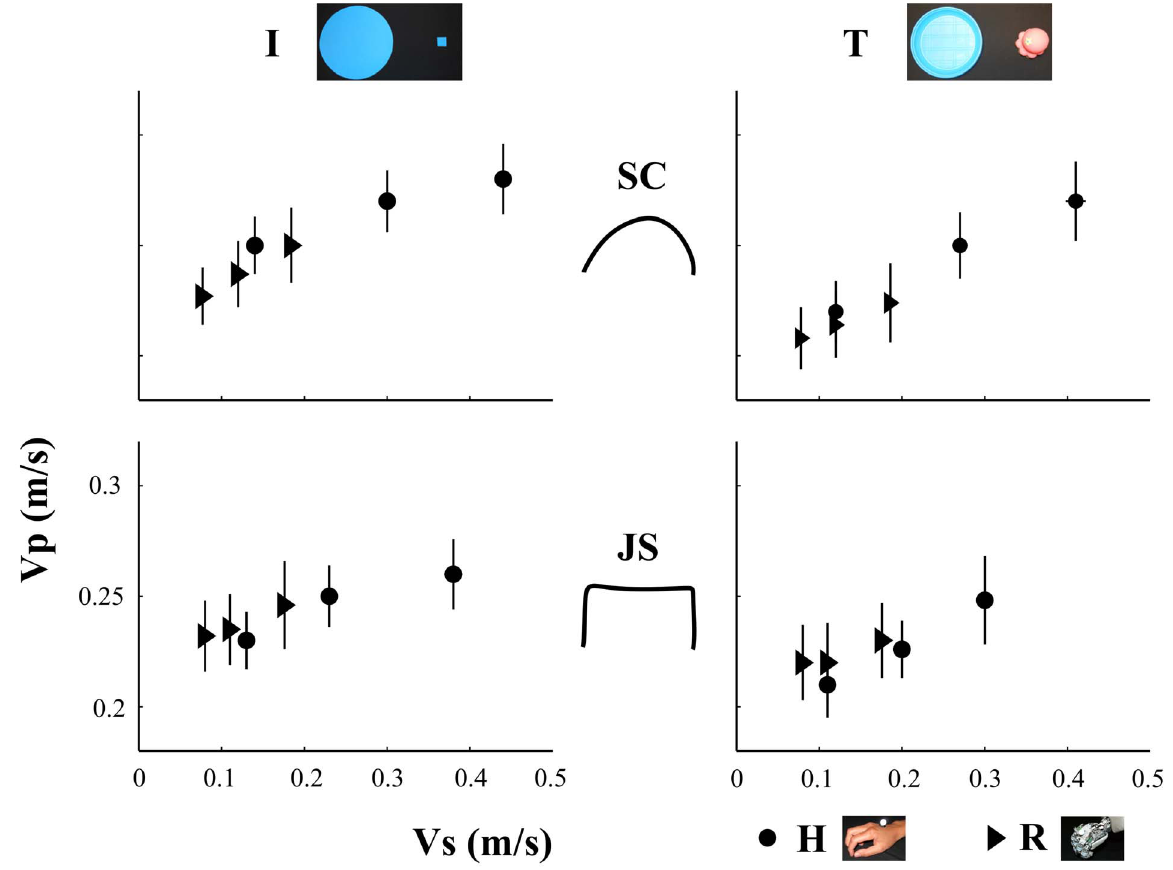
Figure 3. Participants’ mean velocity (y-axis) as function of demonstrators’ velocities (x-axis). Circles and triangles indicate mean V P in response to the observation of human and humanoid demonstrators’ movement, respectively. The columns –refer to intransitive (I-first) and transitive (T-second) movements. The first line displays the responses to smooth-curvilinear (SC) demonstrators’ trajectories, while the second line to jerky-segmented (JS) stimulus trajectories. Vertical and horizontal error bars represent the participants and stimulus standard errors.